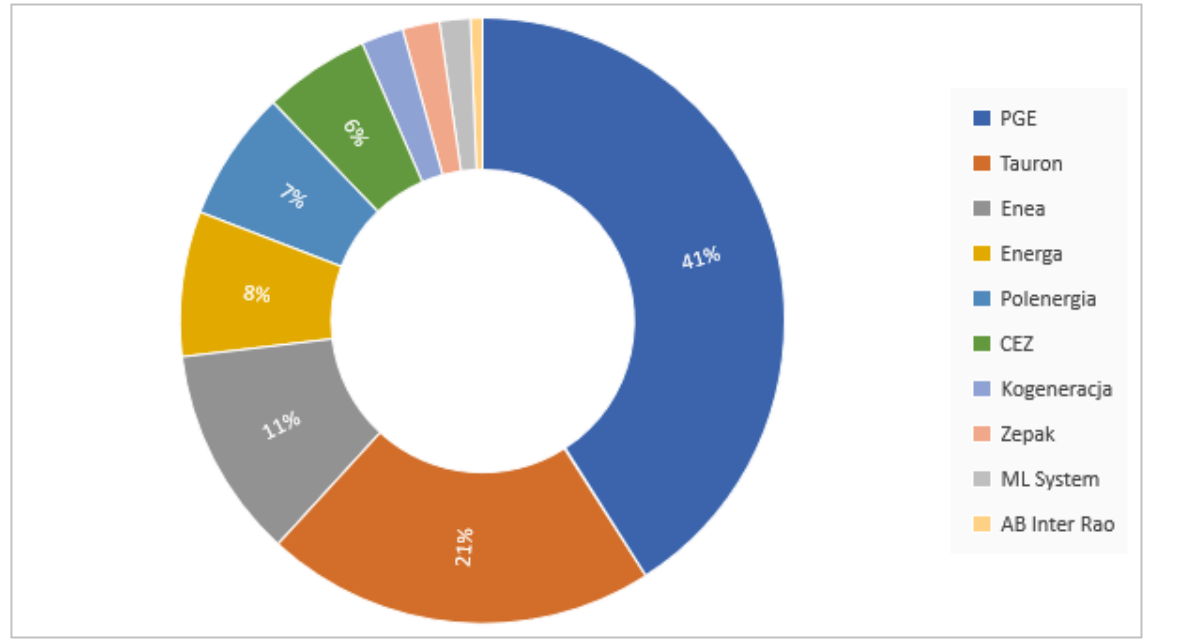
Figure 8. Shares of companies in the WIG-ENERGIA index as of 30 October 2020. Source: author’s study based on: https://profit-journal.pl/raport-sektorowy-energetyka/ access date: 25 August 2021 [60]; bankier.pl (accessed on 23 November 2021).